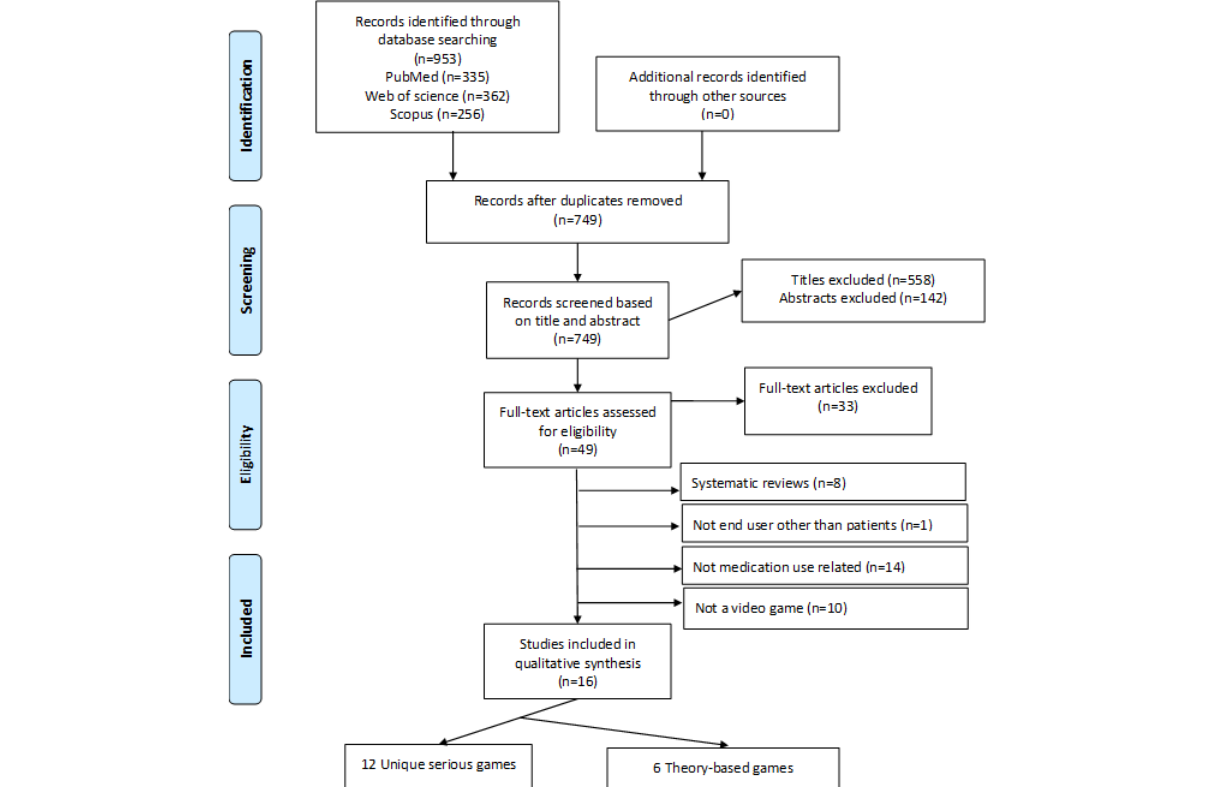
Figure 1. Preferred Reporting Items for Systematic Reviews and Meta-Analyses flow diagram of the included